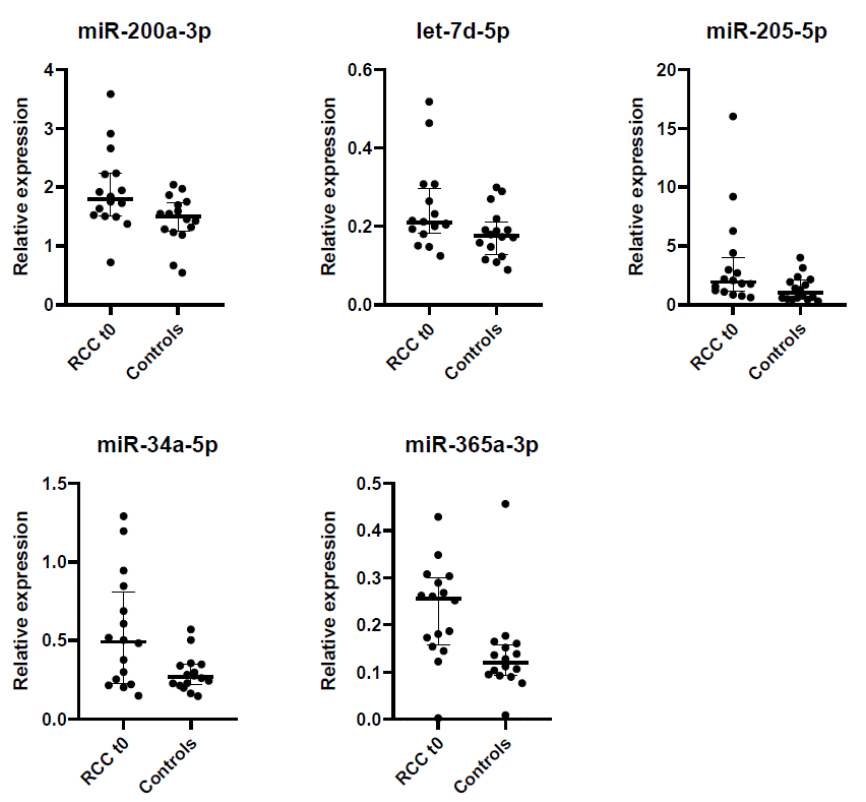
Figure 6. Relative expression of the five dysregulated miRNAs (miR-200a-3p, let-7d-5p, miR-205-5p,